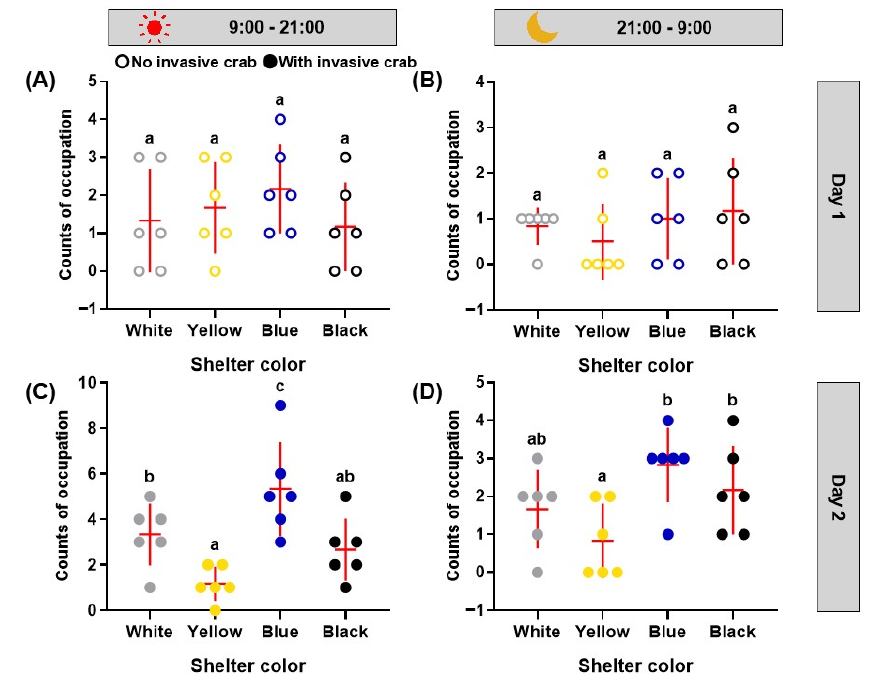
Figure 6. The counts of occupation of different colored shelters: the daytime of Day 1 ( A ), the nighttime of Day 1 ( B ), the daytime of Day 2 ( C ), and the nighttime of Day 2 ( D ). Each colored point represents the count of occupation in each system. Different lowercase letters represent statistically significant differences in the counts of occupation ( p < 0.05).